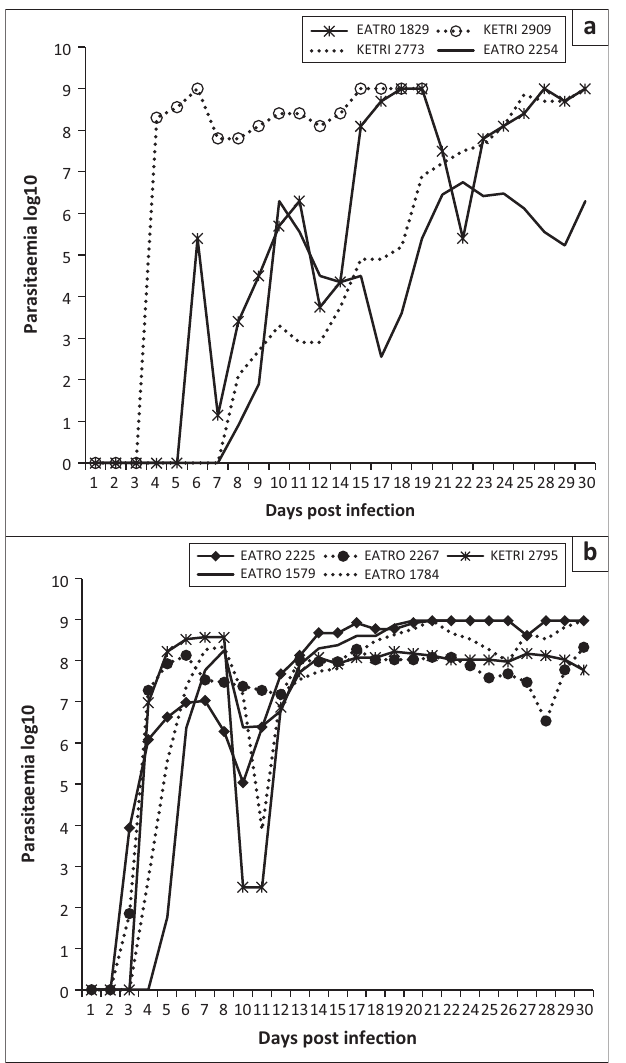
FIGURE 2: Mean packed cell volume profiles of mice (a) ( n = 5) infected with isolates of Trypanosoma congolense savannah and (b) ( n = 6) infected with various isolates of Trypanosoma brucei